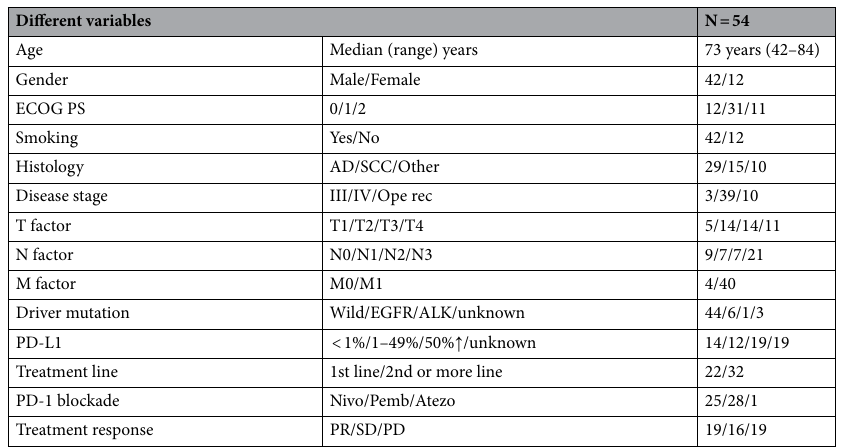
Table 1. Patient’s demographics. ECOG eastern cooperative oncology group, PS performance status, AD adenocarcinoma, SCC squamous cell carcinoma, Ope rec recurrence after operation, PD-L1 programmed death ligand-1, PD-1 programmed death-1, EGFR epidermal growth factor receptor, ALK anaplastic lymphpma kinase, Nivo nivolumab, Pemb pembrolizumab, Atezo atezolizumab, PR partial response, SD stable disease, PD progressive